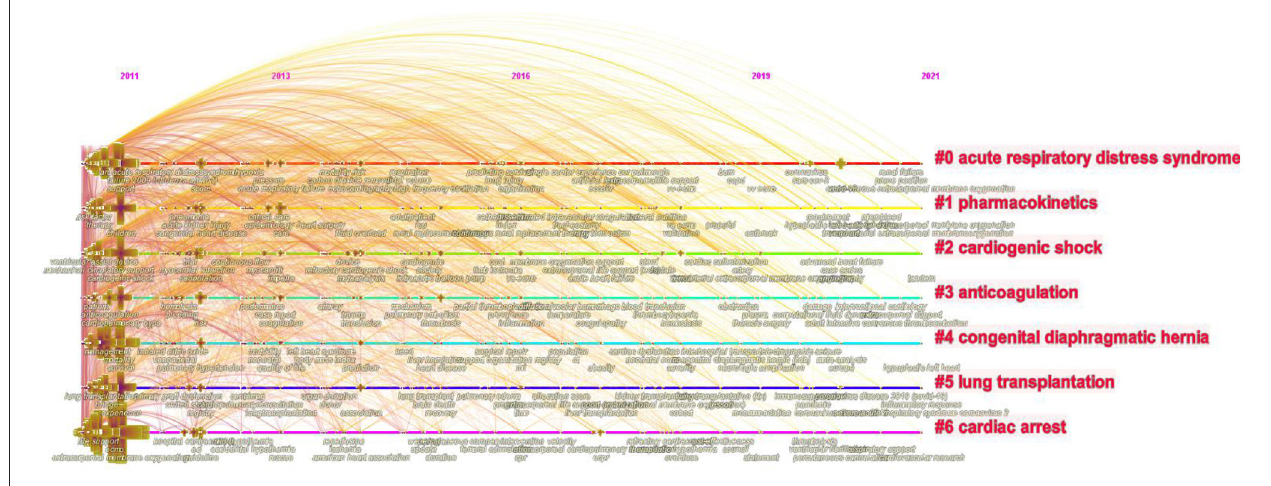
FIGURE 6 | Timeline